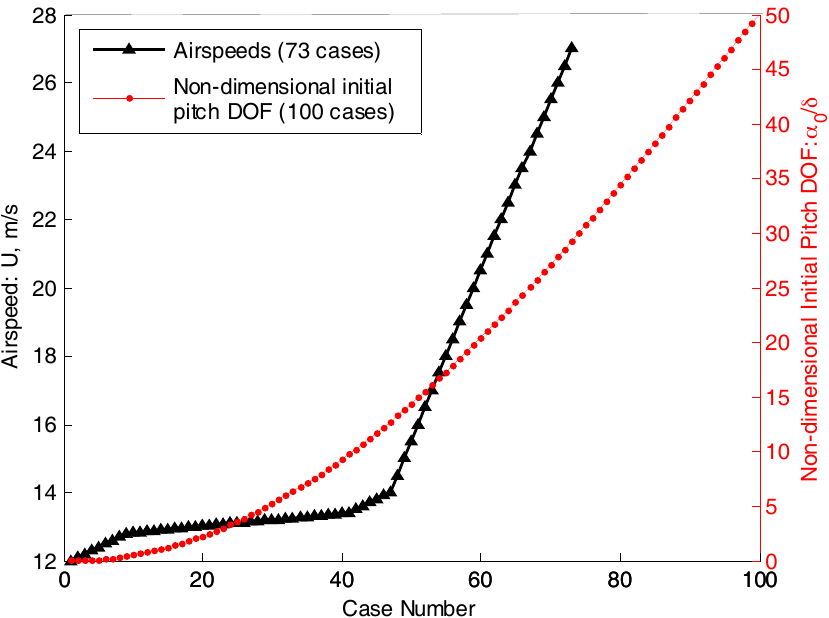
Figure 15. Calculation cases with 73 airspeeds and 100 initial pitch angles for each airspeed.